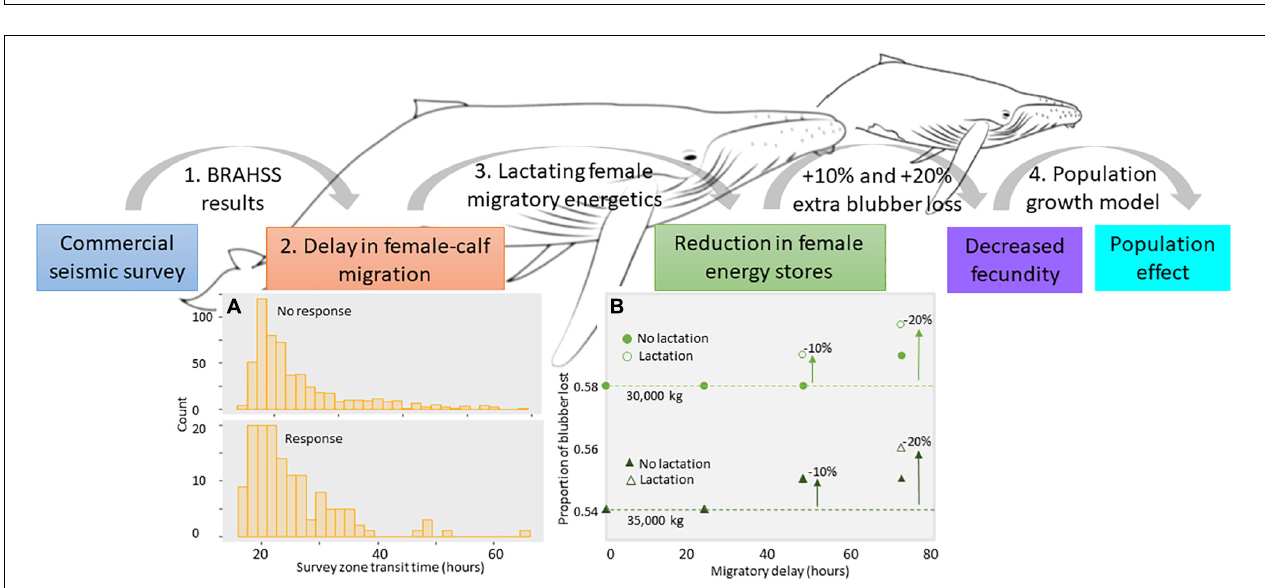
FIGURE 1 | Maps illustrating the dimensions of the simulated commercial seismic survey, positioned off the Queensland coastline in Australia [with map (A) designating the eastern coastline of Queensland, and map (B) showing the simulated seismic air gun area off the Sunshine Coast, Queensland]. White arrows indicate the southwards direction of migration of the whale population from breeding grounds in the Great Barrier Reef through the commercial seismic survey zone (red box). The offshoot arrow in the Queensland map illustrates the use of the Hervey Bay resting area.